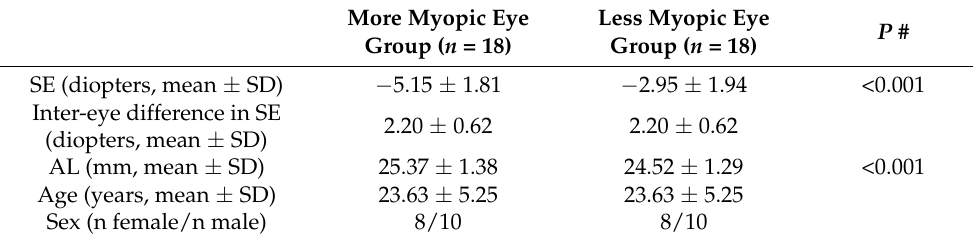
Table 1. Characteristics of the study subjects.